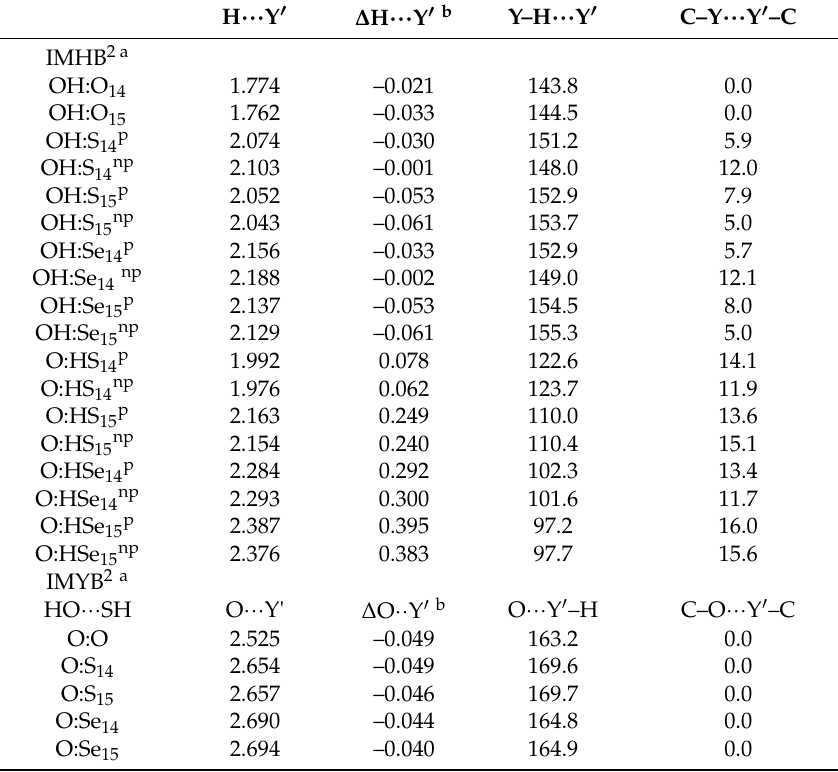
Table 3. Bond lengths (Å), Y–H ··· Y’ angles and dihedral Z–C–C–Z (cid:48) angles ( ◦ ) for the different compounds at MP2/aug-cc-pVDZ computational